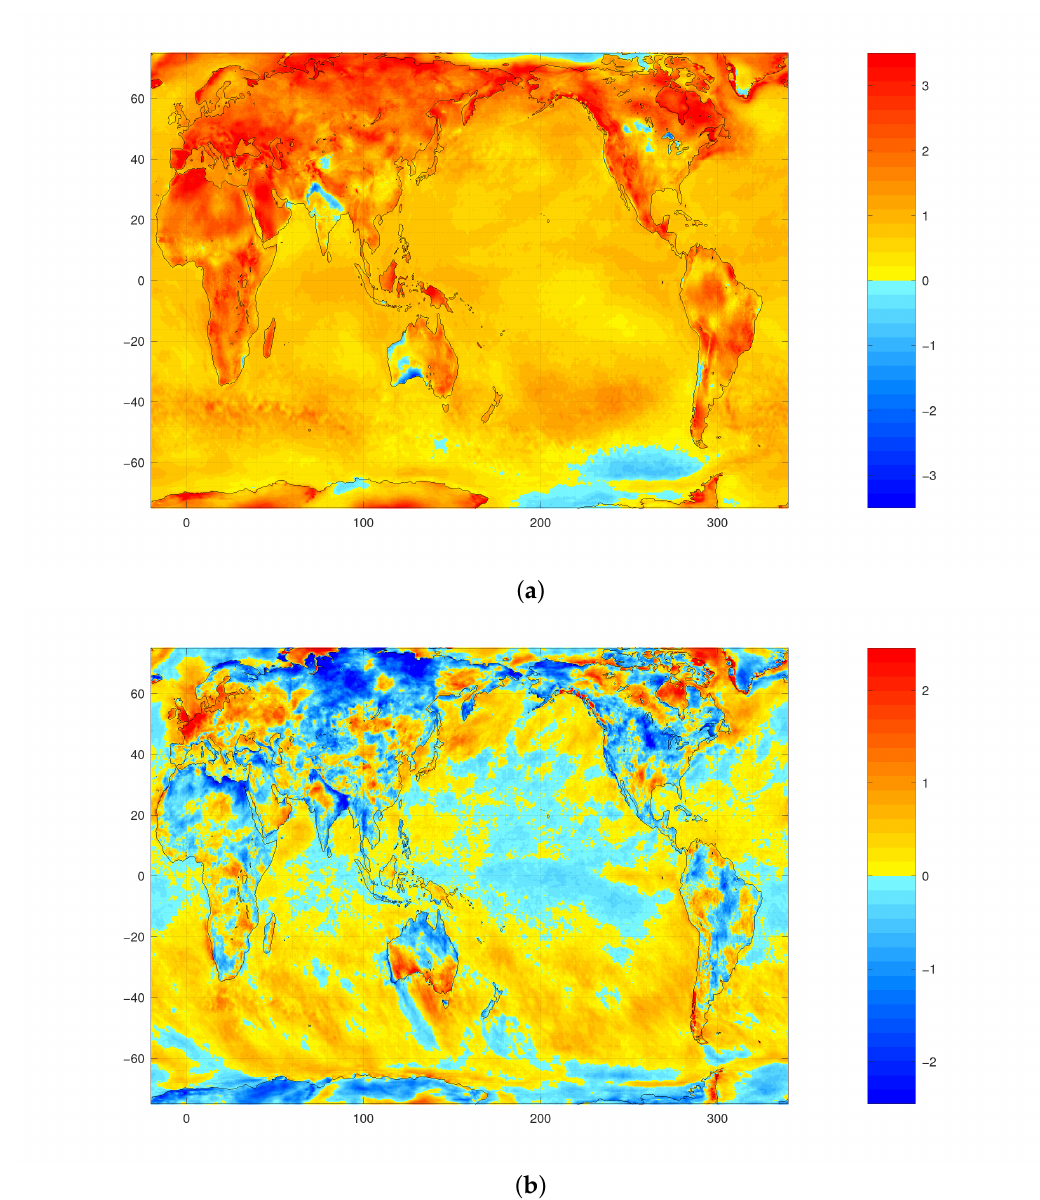
Figure 2. ( a ) Smoothed ERA5 change in T 80 max (K), 1959–2021. ( b ) Smoothed ERA5 change in the difference between TXx and T 80 max (K),